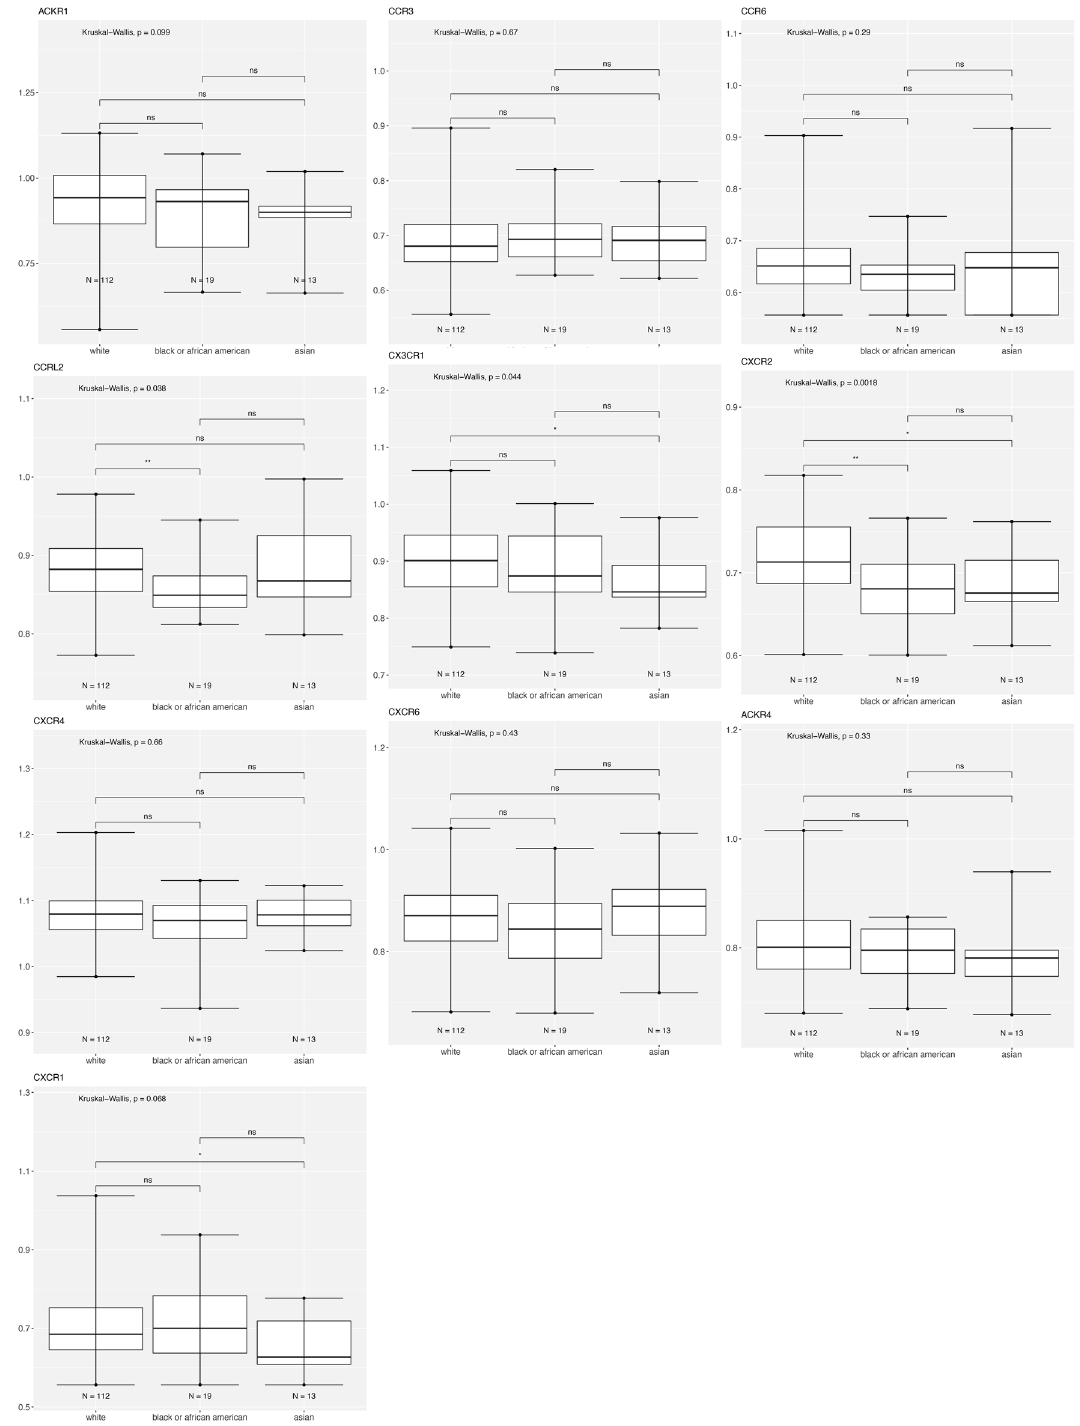
Figure 6. Differentially expressed chemokine receptor gene expression based on race within Luminal B subtype using the breast cancer TCGA data for tumor samples only. Box and whisker plots represent minimum expression at the bottom whisker, maximum at the top whisker and median at the middle line with a Log10 axis scale showing gene expression of the chemokine receptors. Statistical significance was determined with global significance for ANOVA with Kruskal